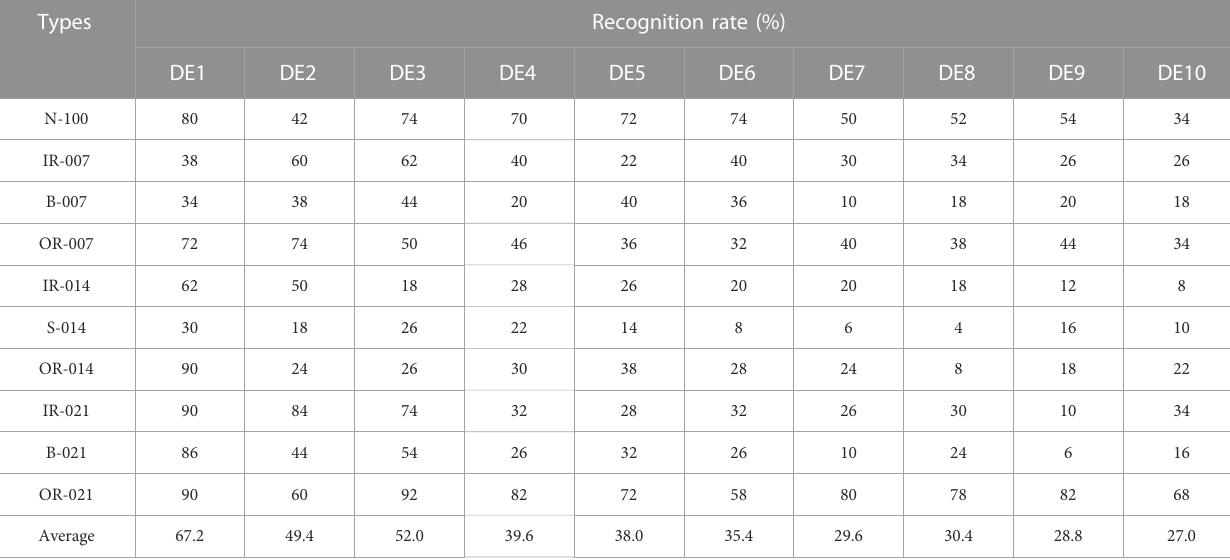
TABLE 1 Single feature recognition results for ten scales of MDE for ten types of signals. Types